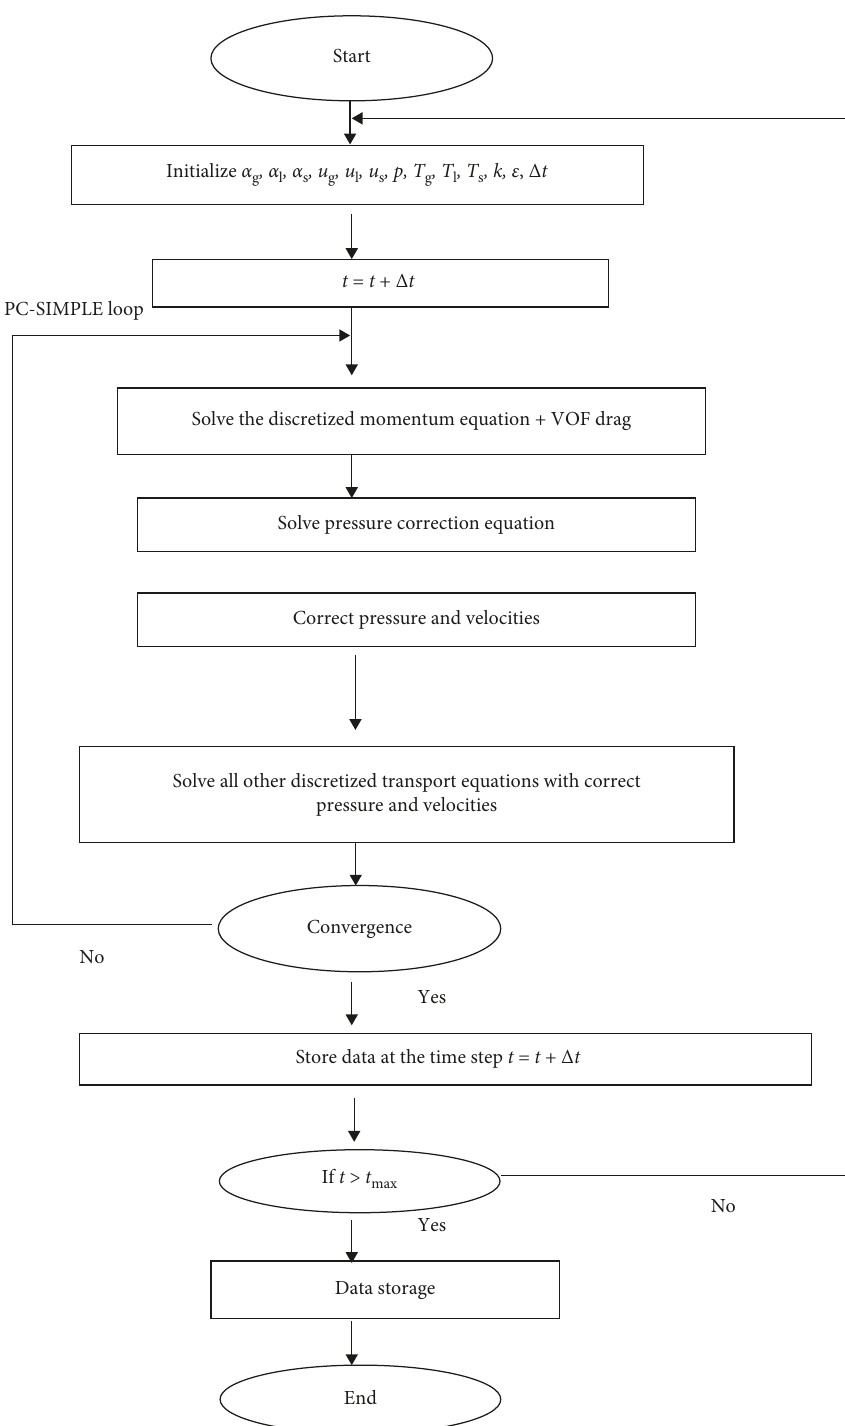
Figure 2: Computing cycle of transient multifluid VOF model for three-phase